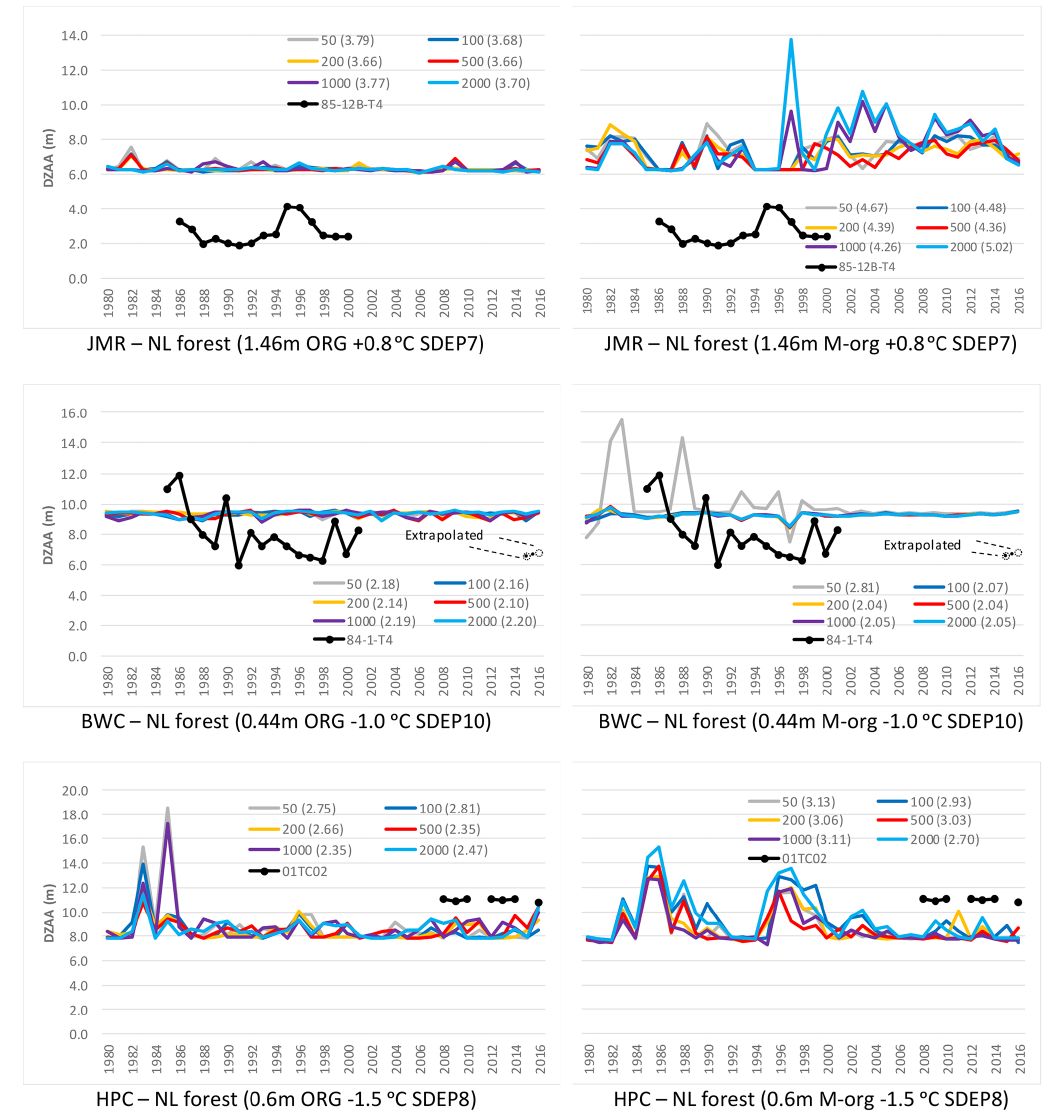
Figure 9. Impact of the number of spin-up cycles on simulated DZAA for the needleleaf forest GRU at all three sites. Two organic configu- rations were used for each site using the SC2 layering scheme; RMSE is shown in